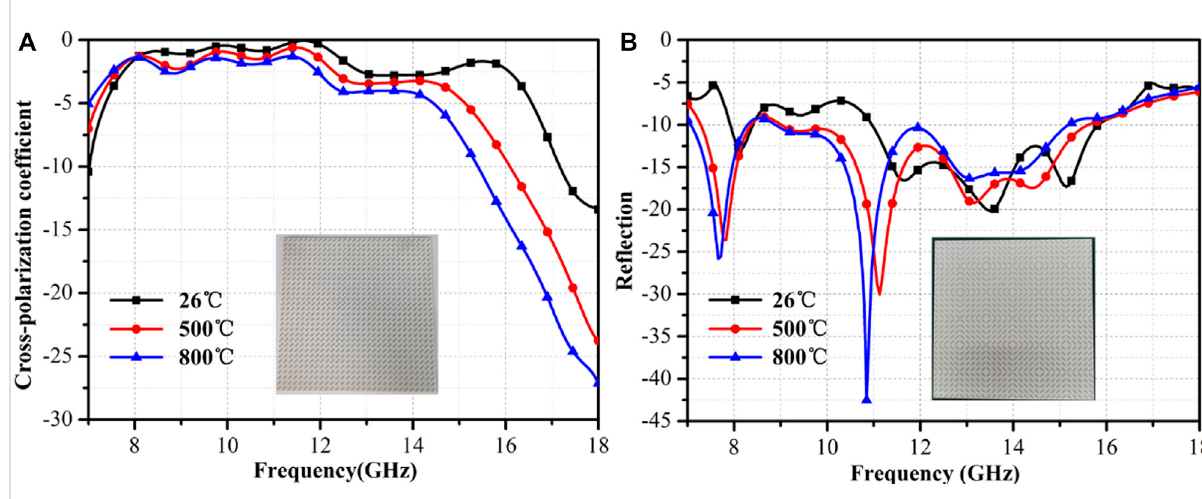
FIGURE 10 (A) Measured cross-polarization coef fi cients for the TE-polarized wave and (B) measured re fl ection results for RCS